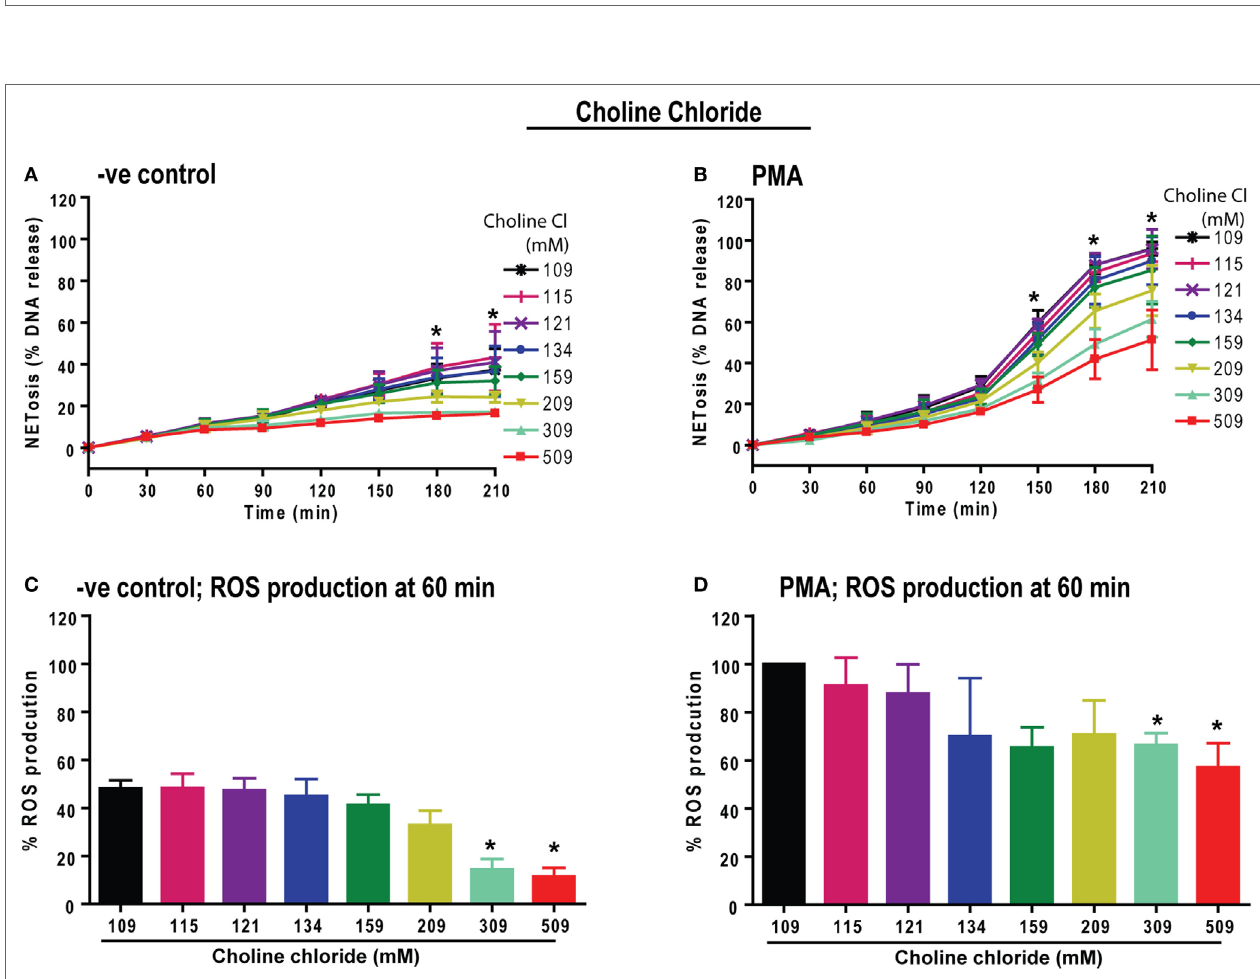
FigUre 2 | Increasing NaCl concentration suppresses phorbol myristate acetate (PMA)-mediated reactive oxygen species (ROS) production and hydrogen peroxide treatment restores NETosis inhibition. Human neutrophils were pretreated with cytosolic ROS indicator dye DHR123 or 2 ′ ,7 ′ -dichlorofluorescein diacetate (DCFDA) in different NaCl concentrated media and were either unstimulated ( − ve control) or activated by PMA (25 nM). ROS production kinetics was performed by plate reader assays up to 60 min. (a) Neutrophils in − ve control show a significant NaCl dose dependent suppression of background ROS generation. (B) ROS generation kinetics in PMA-treated neutrophils also show significant suppression of ROS in later time points for hypertonic saline conditions (309 and 509 mM) compared to the normotonic condition (109 mM). The suppression was statistically significant at time points 40, 50, and 60 min ( n = 3 − 4; * p < 0.05; two-way ANOVA with Bonferroni’s multiple comparison posttest). (c) Neutrophils were stained for DNA and DHR123 to observe ROS production in cytosolic space. Confocal microscopy of DHR123-treated neutrophils with 109, 121, 209, and 509 mM NaCl, confirms a dose-dependent suppression of ROS production at higher concentrations in PMA-activated cells. R123 fluorescence was detected in both 109, and 121 mM but not in 209 and 509 mM NaCl condition. Unstimulated ( − ve control) neutrophils show little or no ROS production ( n = 3 − 4; R123-green; DNA, DAPI blue; scale bar 22 µm). (D) Intracellular ROS production measured using the DCFDA dye showed very minimal ROS production in − ve control, while (e) PMA treatment induced intracellular ROS production, which is dose dependently suppressed with higher NaCl concentration ( n = 3; * p < 0.05; two-way ANOVA with Bonferroni’s multiple comparison posttest). See Figure S3 in Supplementary Material for more salt conditions and low magnification images. Furthermore, during NETosis, hydrogen peroxide was added to human neutrophils after 120 min exposure to different NaCl concentrations. (F) Hydrogen peroxide induced a significant amount of NETosis in a range of varying NaCl concentrations (109 – 509 mM). (g) In addition, Hydrogen peroxide rescued the suppression in PMA-induced NETosis in high salt concentrations, bringing the NETosis levels of neutrophils in 509 mM NaCl close to NETosis levels of neutrophils in 109 mM NaCl ( n = 3; * p < 0.05; two-way ANOVA with Bonferroni’s multiple comparison post